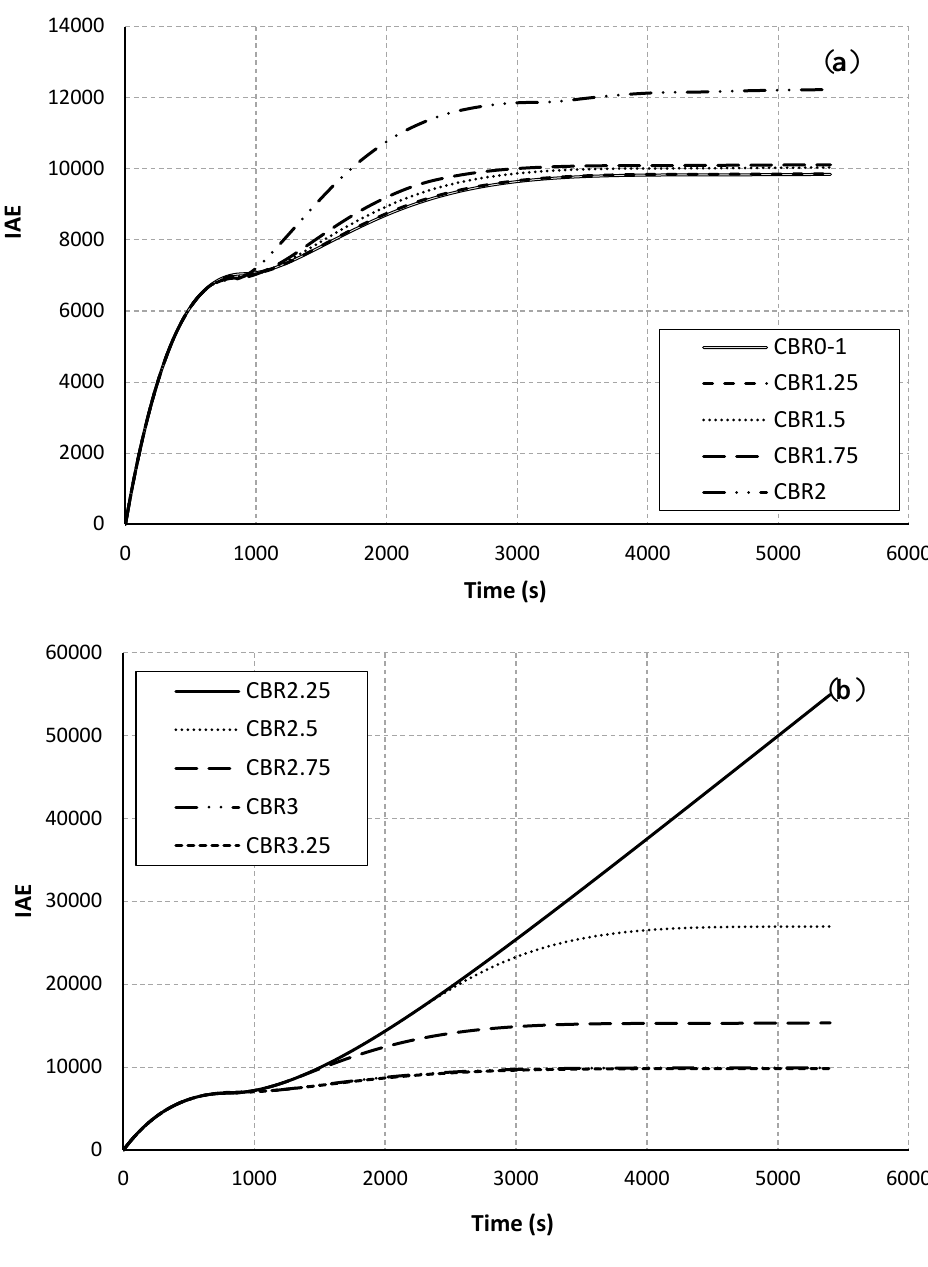
Figure 5. IAE vs . CBR rate. ( a ) Vary the CBR rates from 0 to 2.00 Mbps. ( b ) Vary the CBR rates from 2.25 to 3.25